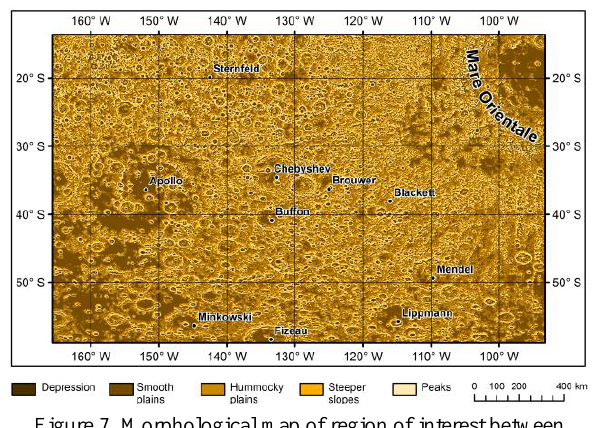
Figure 7. Morphological map of region of interest between South Pole-Aitken basin and Mare Orientale; the DEM 's quality and classified values of RTP and IQR makes it possible to recognize many details